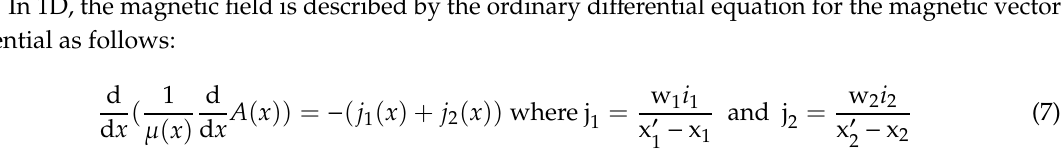
Figure 3. Explanation of a 1D problem for a transformer’s air window.